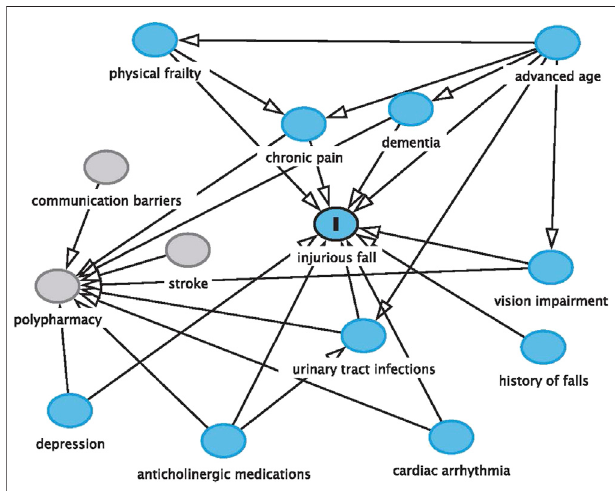
FIGURE 1 | Factors associated with the risk of